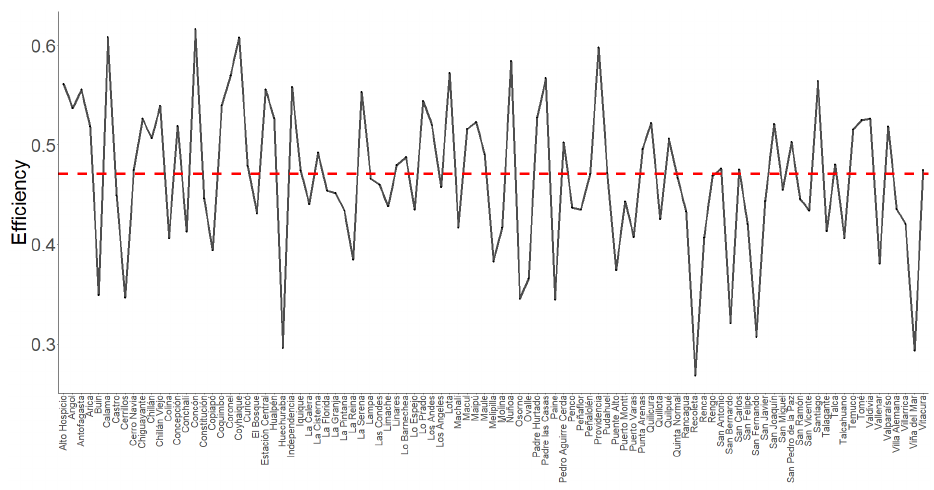
Figure 12. Estimated efficiency per